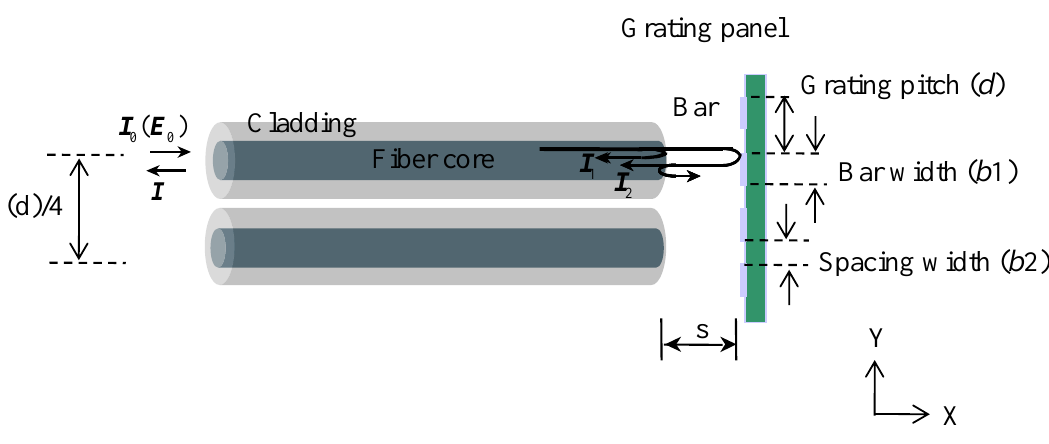
Figure 1. Schematic diagram of the signal